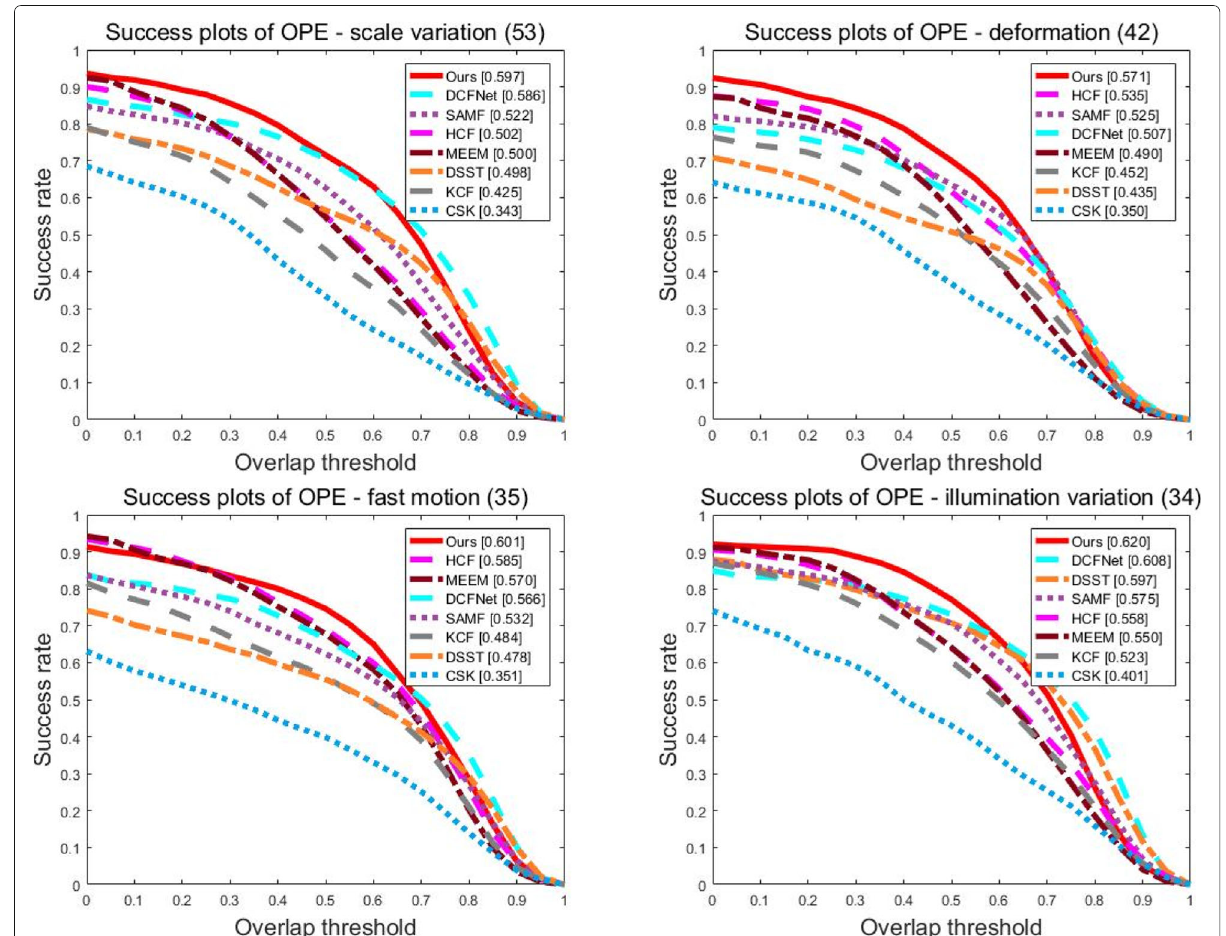
Fig. 8 Overlap success plots in sequence with deformation, fast motion, illumination variation, and scale variation